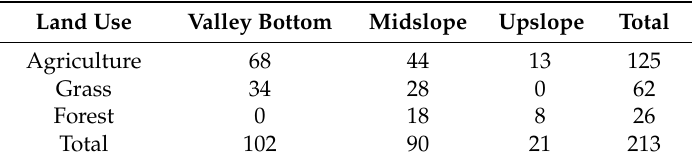
Table 3. Landscape position and land use of recharge areas contributing to the springs and wells. Land Use Valley Bottom Midslope Upslope Total Agriculture 68 44 13 125 Grass 34 28 0 62 Forest 0 18 8 26 Total 102 90 21